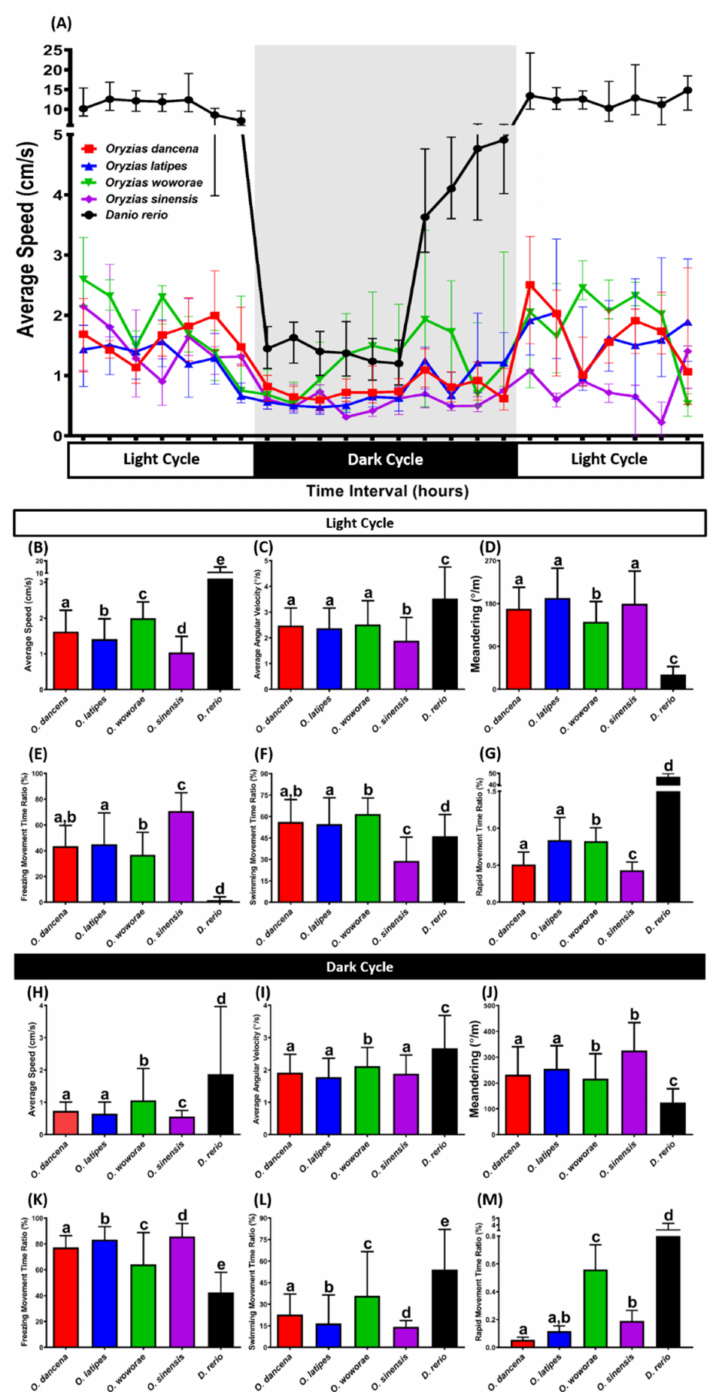
Figure 5. The circadian locomotor activity rhythm of medaka fish and AB strain zebrafish as the outgroup. ( A ) Comparison of the average speed between each tested fish species (medaka and zebrafish) during the day and night cycles. Comparisons of ( B , H ) average speed, ( C , I ) average angular velocity, ( D , J ) meandering, ( E , K ) freezing movement time ratio, ( F , L ) swimming movement time ratio, and ( G , M ) rapid movement time ratio between each tested fish species (medaka and zebrafish) in the day and night cycles, respectively. Data are presented as median with interquartile range, except for ( G , M ), which are presented as mean with a 95% confidence interval (CI) since some median of the data in those figures are 0. Data were analyzed by Kruskal–Wallis test continued with uncorrected Dunn’s test. Different letters (a, b, c, d, e) on the error bars represent a significant statistical difference ( p < 0.05) ( n = 18 for O. dancena , O. latipes , O. woworae , and D. rerio ; n = 12 for O. sinensis